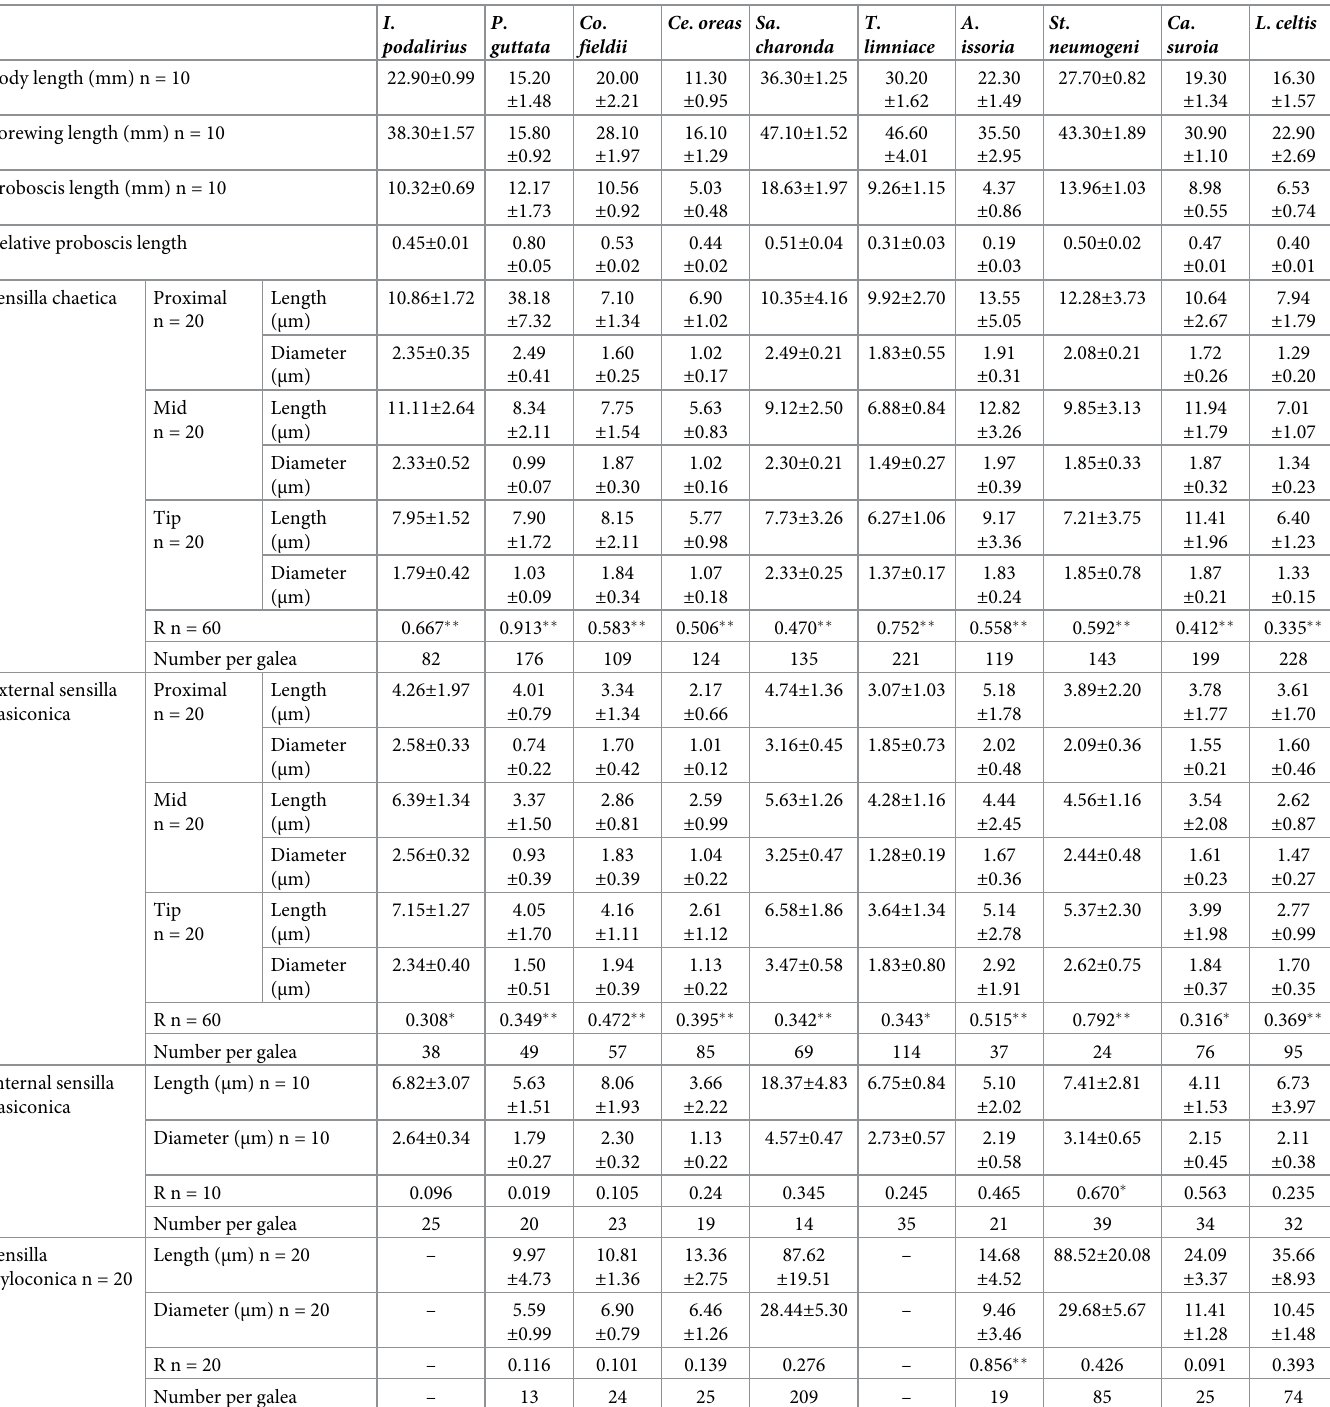
Table 2. Body length, forewing length, proboscis length and length, diameter and number of various sensilla of ten